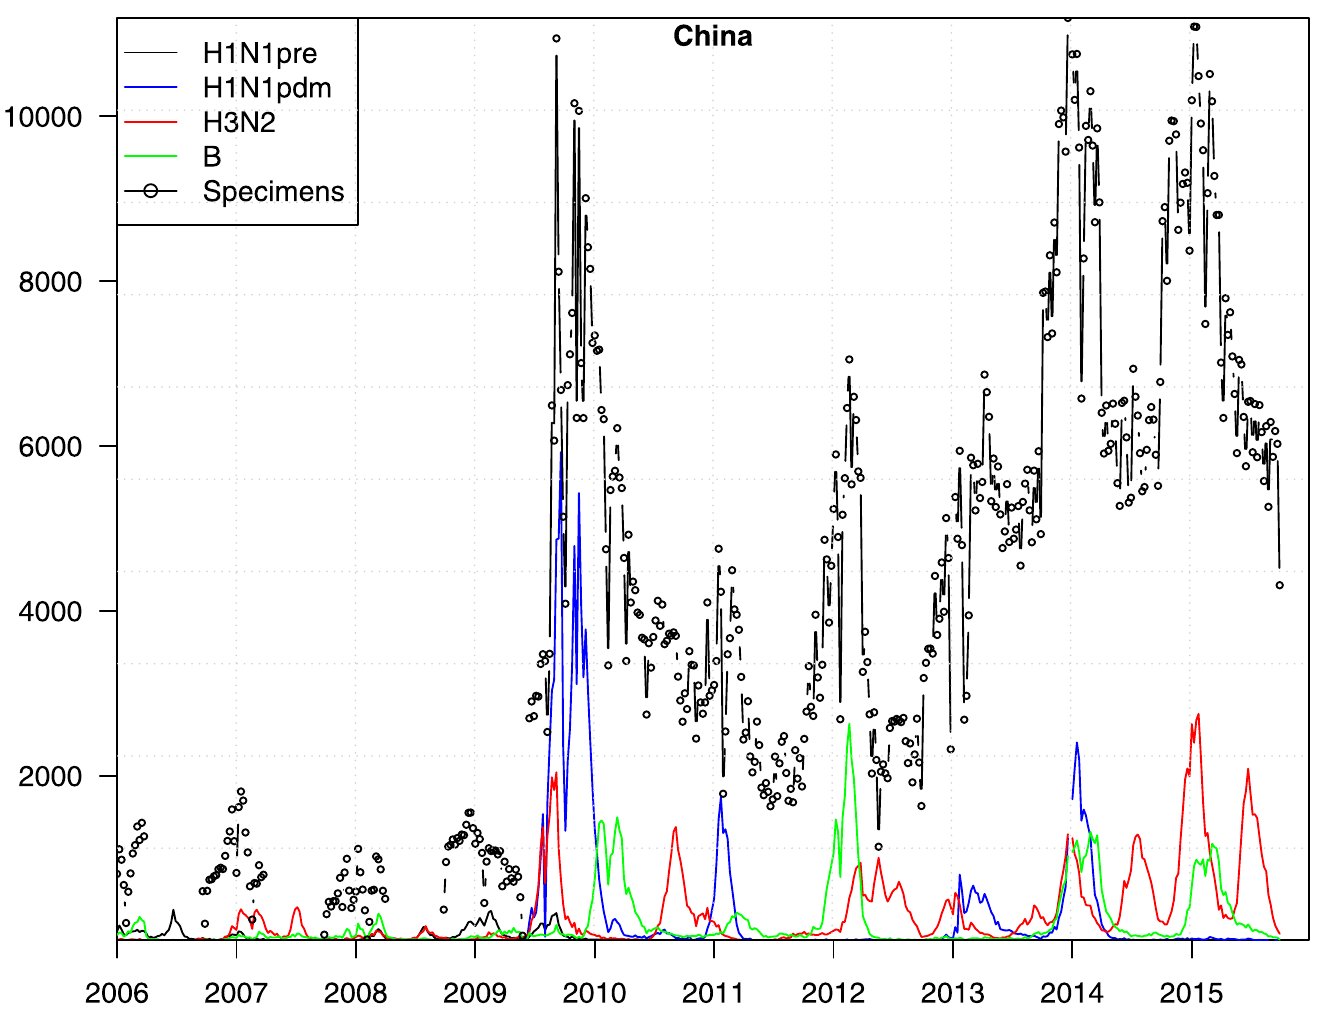
Fig 4. Weekly total of specimens tested for influenza and laboratory confirmed H1N1, H3N2 and influenza B cases.